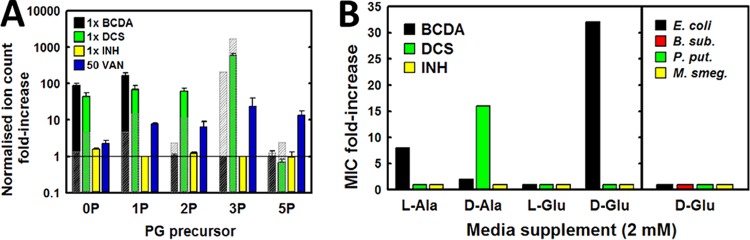
BCDA inhibits incorporation of d-Glu into nascent peptidoglycan precursors. (A) Fold change in intracellular levels of PG precursors in H37Rv, relative to untreated control cultures, following 24 h of challenge with various compounds at the specified concentrations. No MIC could be determined for vancomycin (VAN) using the filter-growth method, and therefore a concentration of 50 μg ml−1 was chosen based on published results (16). Translucent gray-shaded bars represent equivalent values measured in B. subtilis. Results are the averages ± SEM from at least duplicate independent experiments. (B) Fold change in MIC for H37Rv (left window) following supplementation of growth media with 2 mM l-Ala, d-Ala, l-Glu, or d-Glu. Data for l-Ala and d-Ala are taken from Fig. 2 and are shown here again for comparison. The right window shows the fold change in the BCDA MIC for four alternative bacterial species following supplementation of media with 2 mM d-Glu. See also Fig. S3 in the supplemental material.